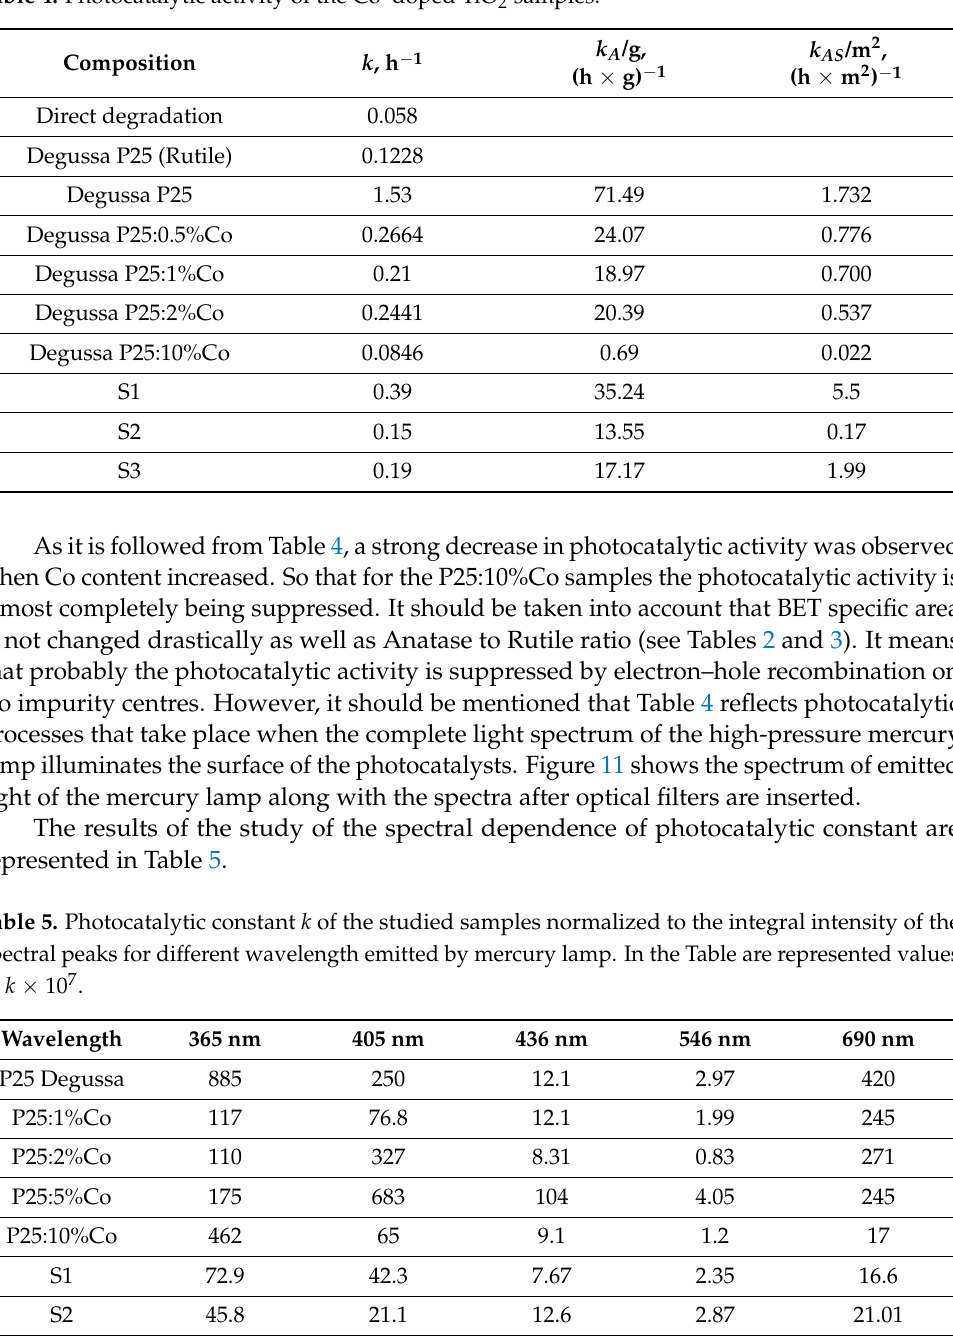
Table 4. Photocatalytic activity of the Co–doped TiO 2 samples.